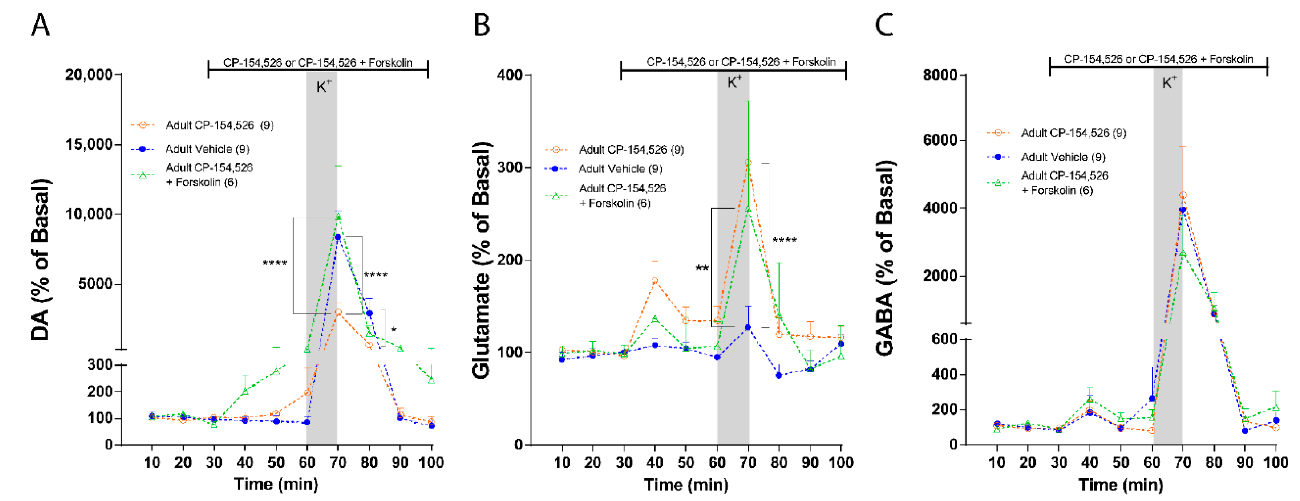
Figure 7. CRF-R1 signaling pathway in NAc of adult rats. Measurement of NAc extracellular neurotransmitter levels using in vivo microdialysis, the vertical gray bars indicate the time of NAc local infusion of 70 mM K+-aCSF, and the horizontal black lines indicate the time of intra-NAc infusion of the antagonist, vehicle, or co-infusion of antagonist with Forskolin. ( A ) NAc DA levels in the presence of aCSF (blue dotted line; n = 9), 10 µM of CP154,526 (orange dotted line; n = 9) and 10 µM of CP154,526 + 50 µM of Forskolin (green dotted line; n = 6). DA levels were normalized to the av- erage of the first 3 values for each condition and expressed as percentage. Two-way ANOVA re- vealed no effect of treatment (F (2, 21) = 3.278, p = 0.0577), a main effect of time (F (9, 189) = 32.31, p < 0.0001), and treatment × time interaction (F (18, 189) = 3.246, p < 0.0001; CP154,526 vs. aCSF, **** p < 0.0001, * p = 0.0210, CP154,526 + Forskolin vs. aCSF, n.s. p > 0.9999, Bonferroni post hoc test). ( B ) NAc glutamate levels in the presence of aCSF (blue dotted line; n = 9), 10 µM of CP154,526 (orange dotted line; n = 9) and 10 µM of CP154,526 + 50 µM of Forskolin (green dotted line; n = 6). Glutamate levels were normalized to the average of the first 3 values for each condition and expressed as